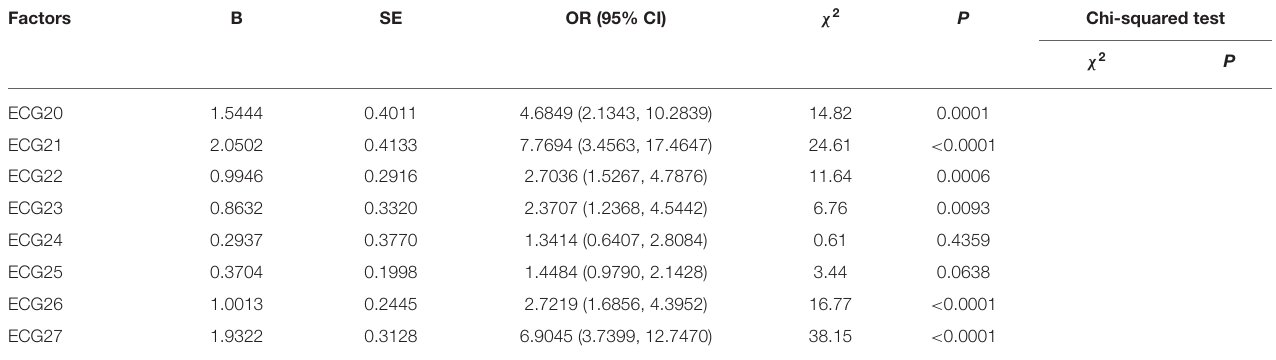
TABLE 4 | The result of multivariate logistic regression analysis.